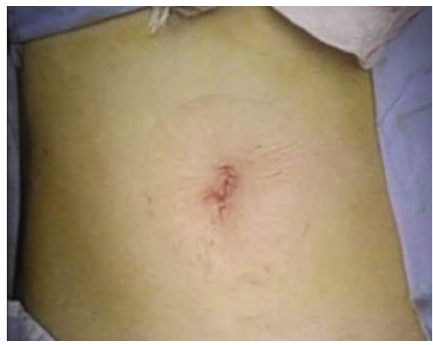
Figure6:Thecosmeticoutcomeofthewound,whichwasconcealed in the umbilicus after gasless laparoendoscopic single-site myomec-